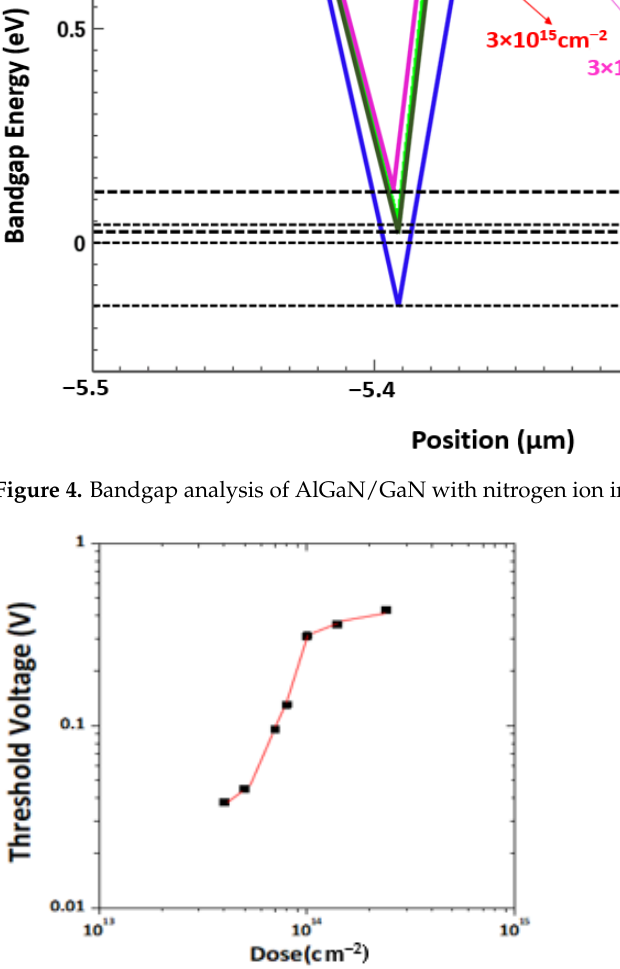
Figure 5. Trend Curve for Dose vs. Threshold Voltage.